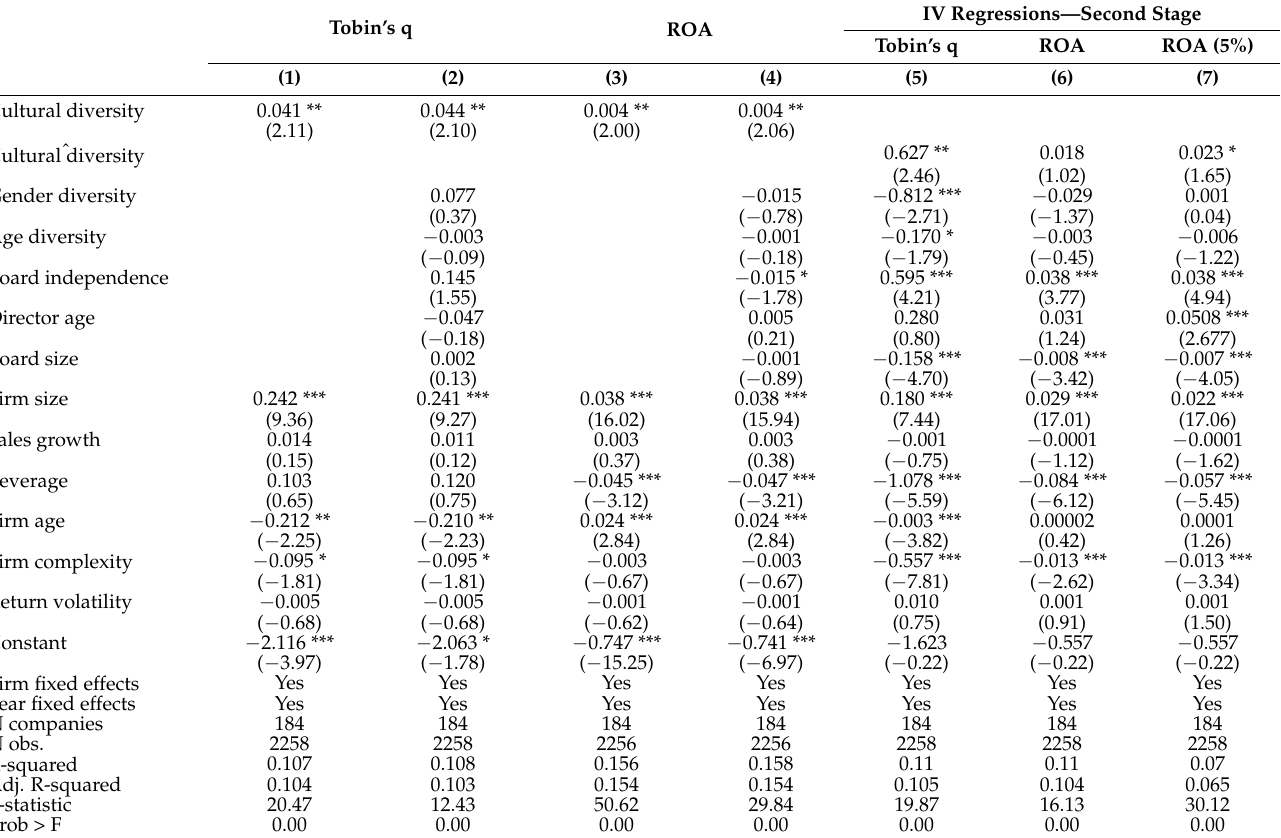
Table 4. Board cultural diversity and firm performance: Main